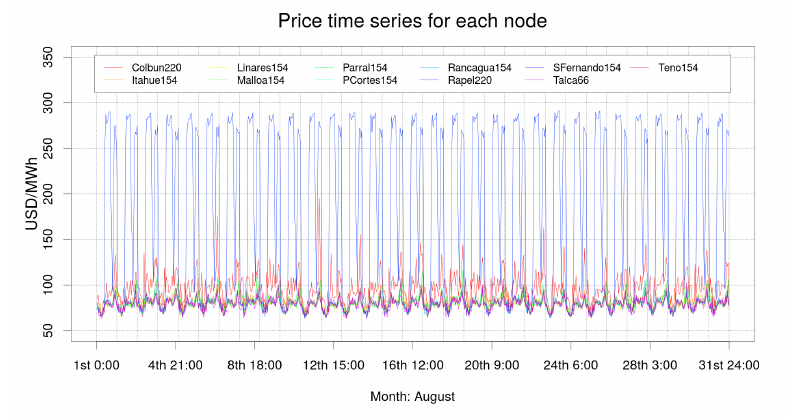
Figure 9. Spot price time series for each existing substation on the studied region for P50 and for the whole month of